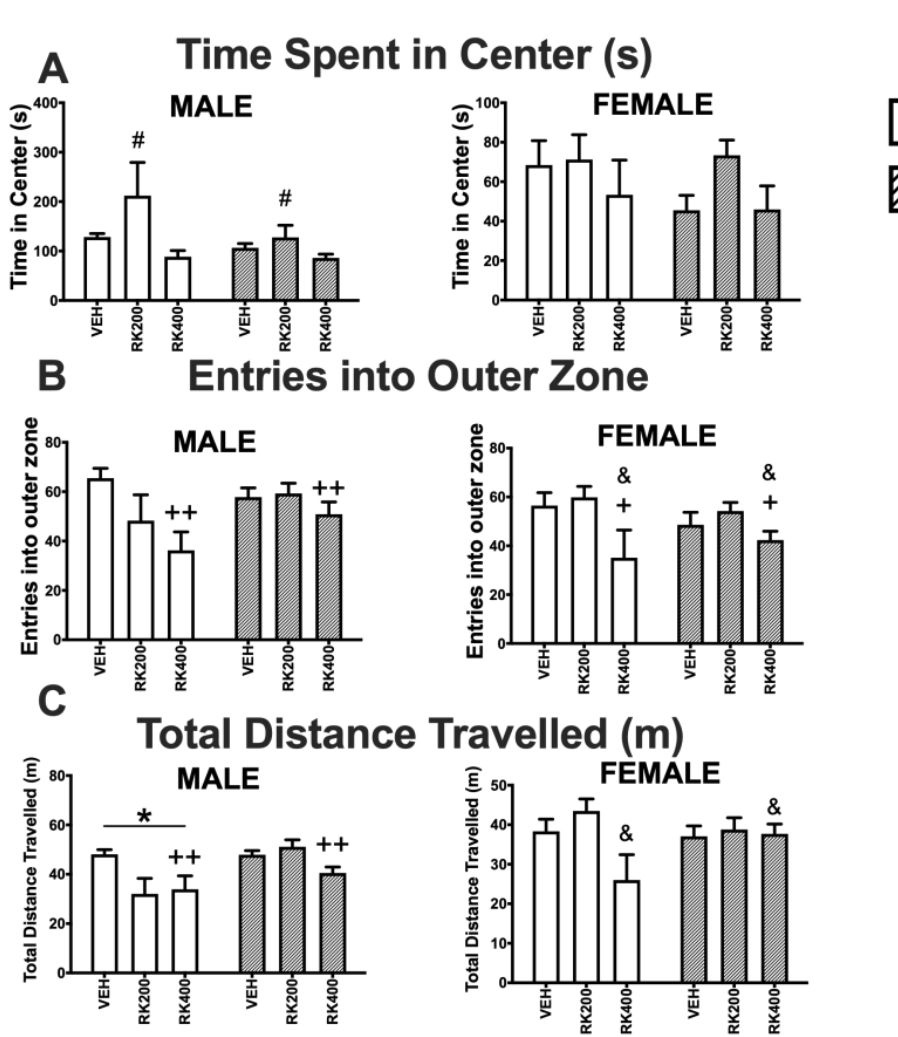
Figure 3. Open-field test during daily oral RK and diet access. Open field tests were performed during days 18–20 of daily dosing and diet access. Data are represented as means ± standard error of the mean (SEM). High-fat diet (45% fat; HFD, solid lines) and low-fat diet (10% fat; LFD, stripped